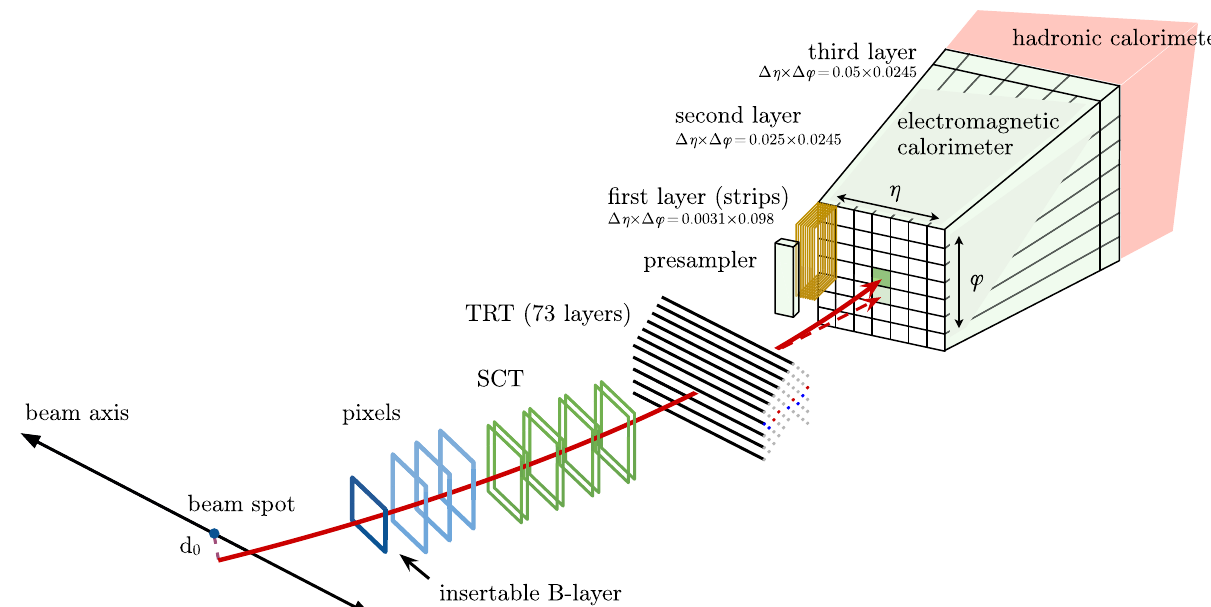
Fig. 1 A schematic illustration of the path of an electron through the detector. The red trajectory shows the hypothetical path of an electron, which first traverses the tracking system (pixel detectors, then silicon- strip detectors and lastly the TRT) and then enters the electromagnetic